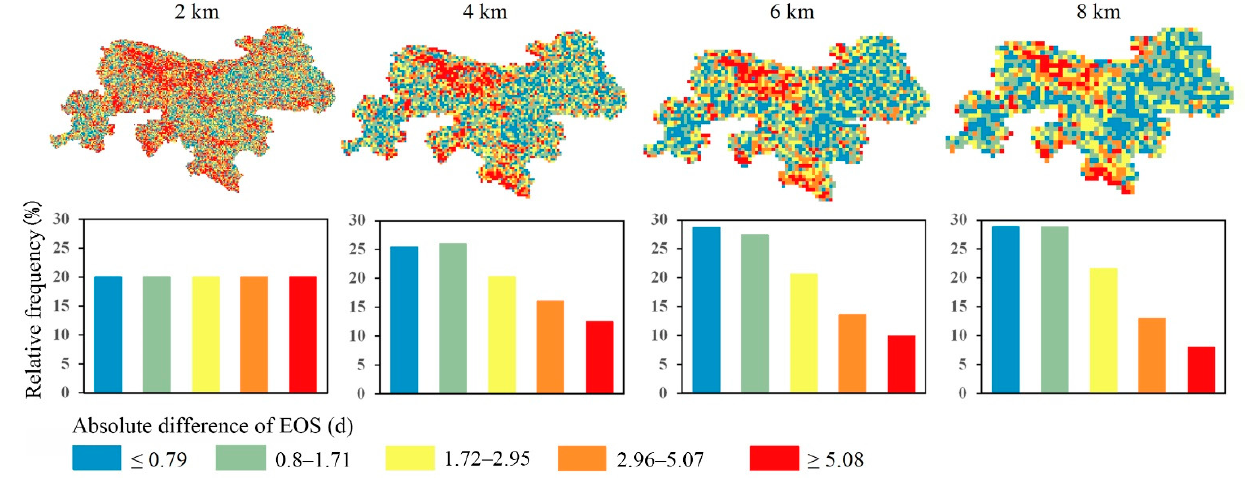
Figure 14. Absolute differences between the up-scaled results from 250 m and 1000 m EOSs retrieved by AG-filtering. Days 0.79, 1.71, 2.95, and 5.08 correspond to the 20%, 40%, 60%, and 80% cumulative frequency of the 2 km EOS difference, respectively.